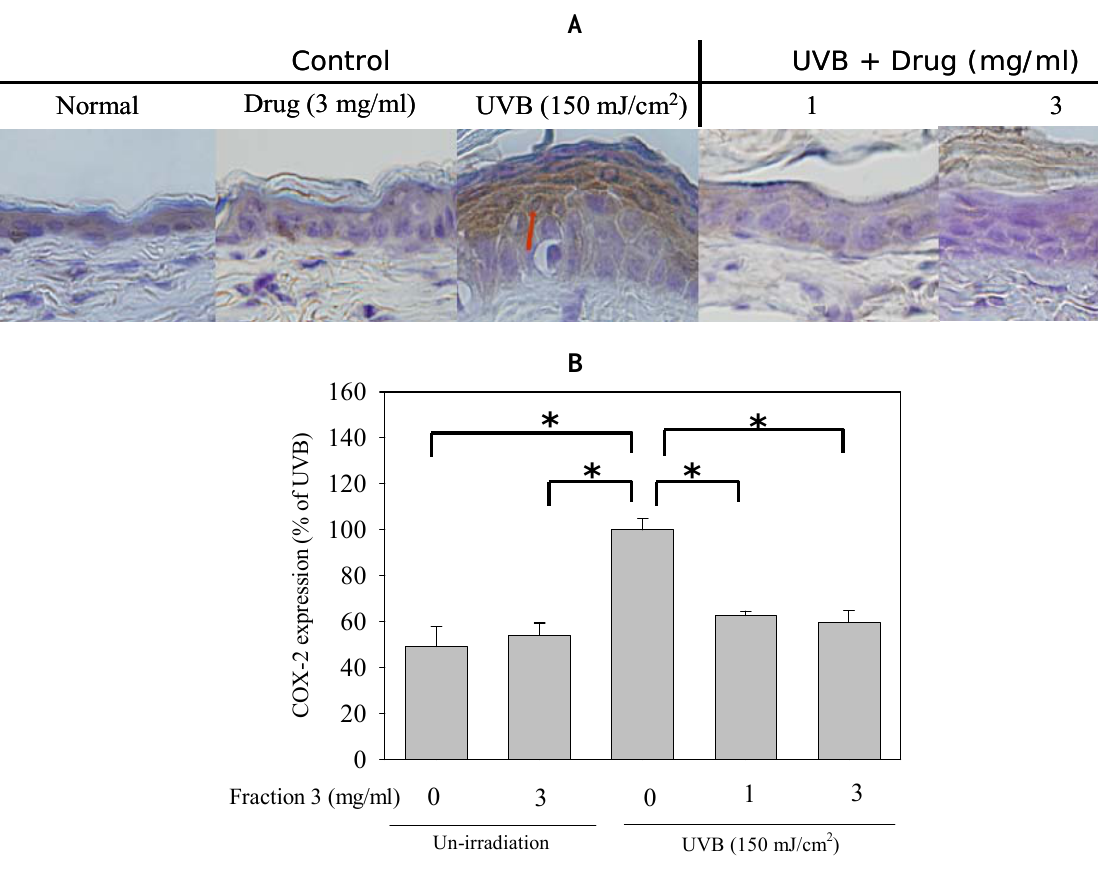
Figure 6. Fraction 3 inhibits UVB irradiation increased COX-2 expression. ( A ) COX-2 expression by immunohistochemistry, magnification 400 X. ( B ) Quantification of COX-2 expression by counting positively staining cells, mean ± S.E. (n = 4). * p < 0.05 compared to the control